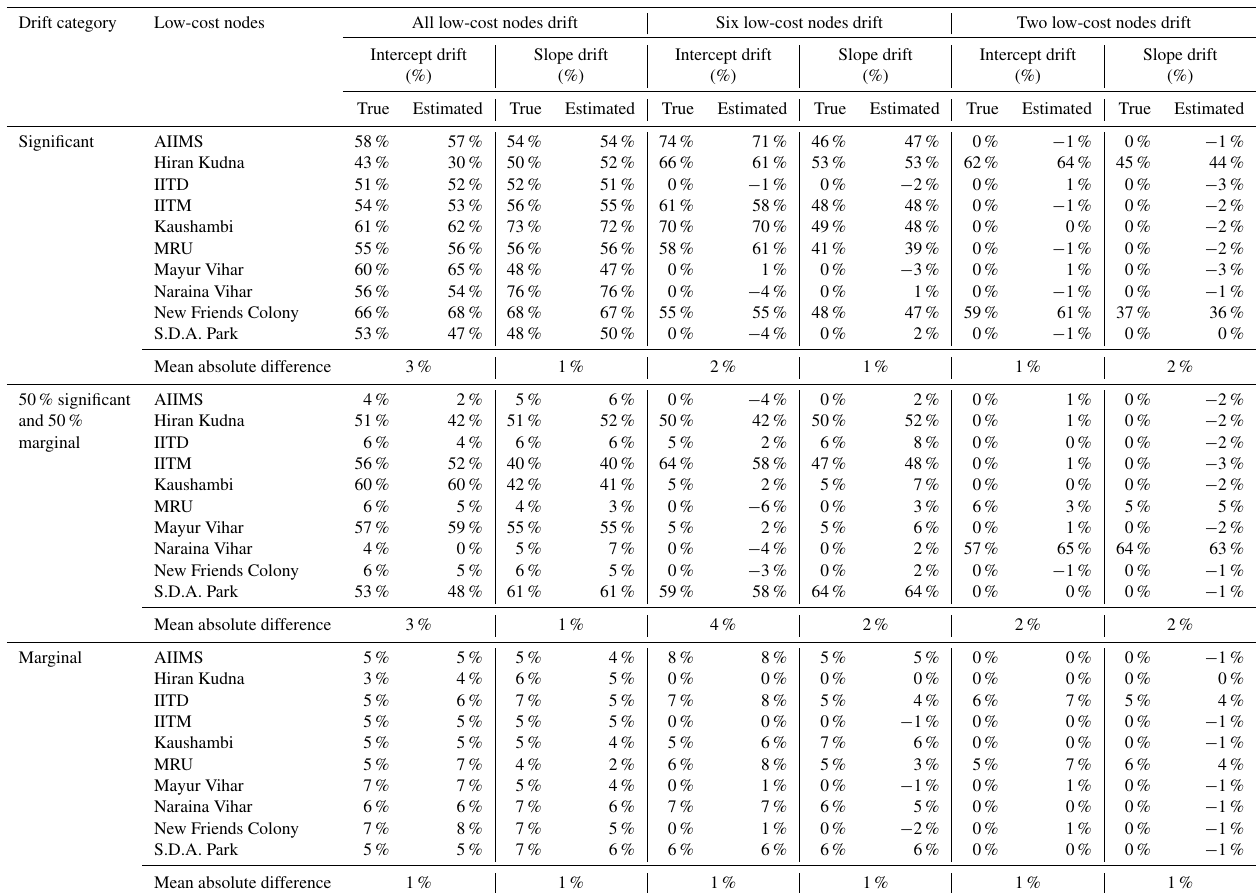
Table 3. Comparison of predetermined percentages of drift to those estimated from the GPR model for intercept and slope, respectively, for each individual low-cost node, assuming all (10), six, and two of the low-cost nodes developed various degrees of drift such as significant (11%–99%), marginal (1%–10%), and a balanced mixture of significant and marginal. Note the sensors that drifted, the percentages of drift, and which sensors drifted significantly or marginally are randomly chosen. The results reported under each scenario are based on averages of 10 simulation